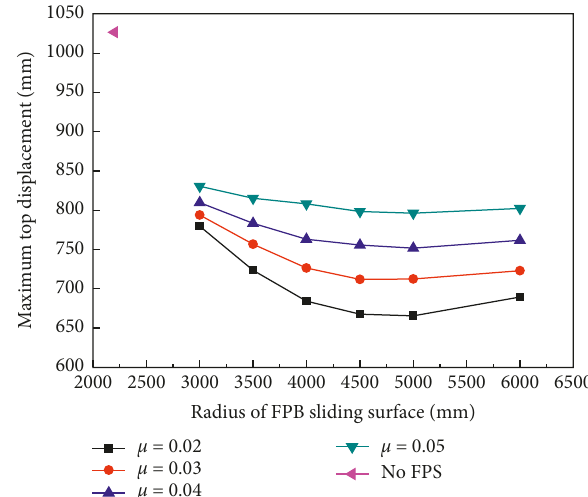
Figure 21: The maximum top displacement of T4S tower with R d and μ in the X direction under L0689S